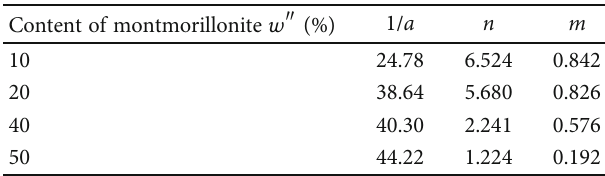
Figure 11: van Genuchten model parameters vary with clay fraction content. Table 6: Fitting parameters of the van Genuchten model modi fi ed with di ff erent montmorillonite